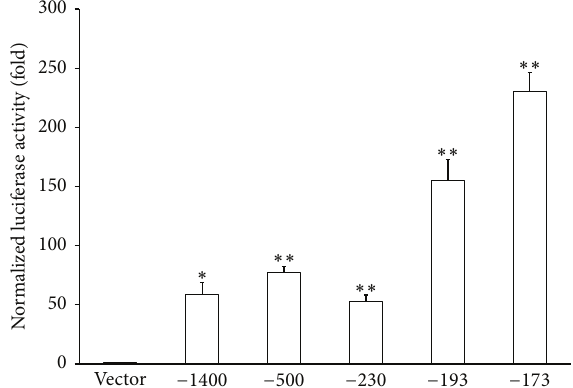
Figure 1: CXCL-8 promoter activities in the presence of HEV genomic RNA. HuH-7 cells were cotransfected with HEV genomic RNA and CXCL-8 promoter-luciferase reporters of different lengths or a luciferase reporter vector without the CXC-8 promoter. Luci- ferase assay was performed 48 hours after transfection. Luciferase activity was normalized against the protein concentration of the same samples. ∗ : p ≤ 0.05; ∗∗ : p ≤ 0.01 by Student’s 𝑡